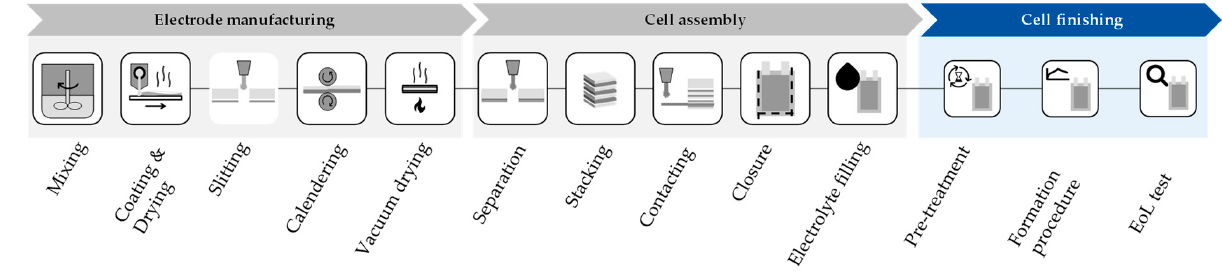
Figure 1. Overview of the production steps in battery cell production (authors’ illustration) .